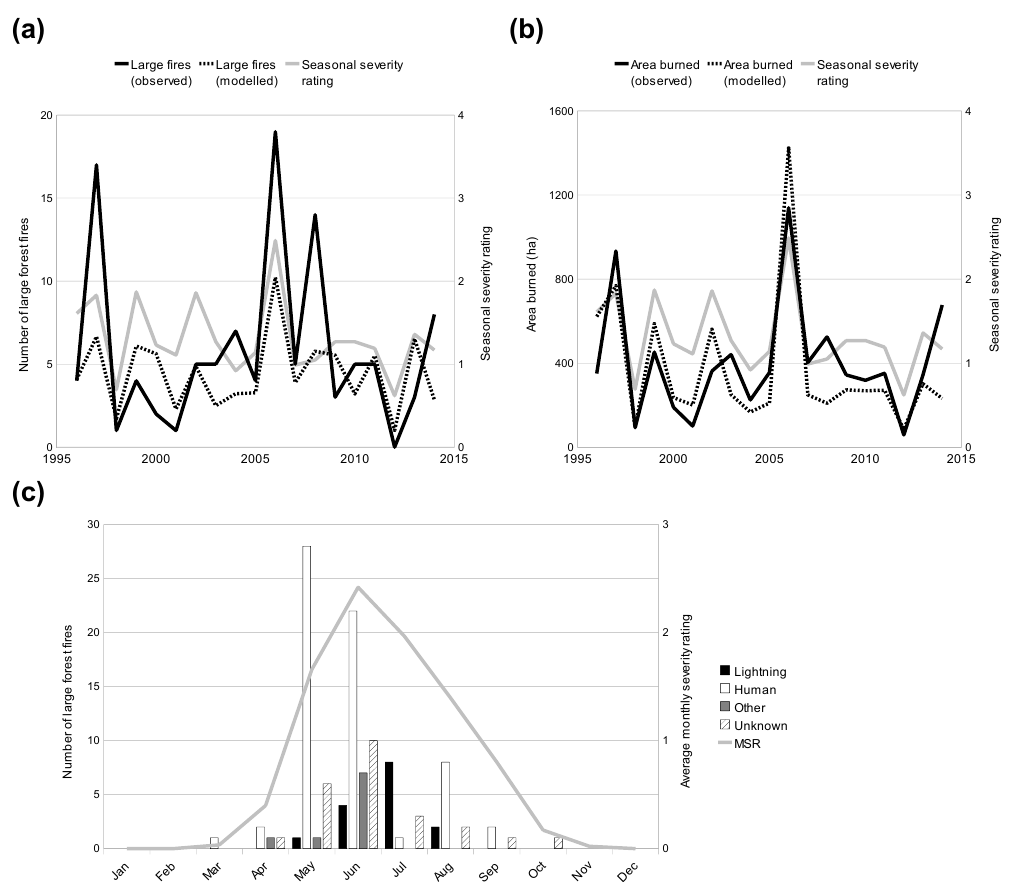
Figure 7. (a) Annual observed (solid black line) and modelled (dashed black line; based on Eq. 3) numbers of large forest fires in Finland during 1996–2014, as well as the annual April–October seasonal severity rating averaged over the whole of Finland (grey line). (b) Annual observed (solid black line) and modelled (dashed black line; based on Eq. 4) area burned in Finland during 1996–2014, as well as the annual April–October seasonal severity rating averaged over the whole of Finland (grey line). (c) Nationwide average of monthly severity rating (MSR) in Finland during 1996–2014 (grey line) and monthly distribution of large forest fires in Finland within the same period, divided by the source of ignition